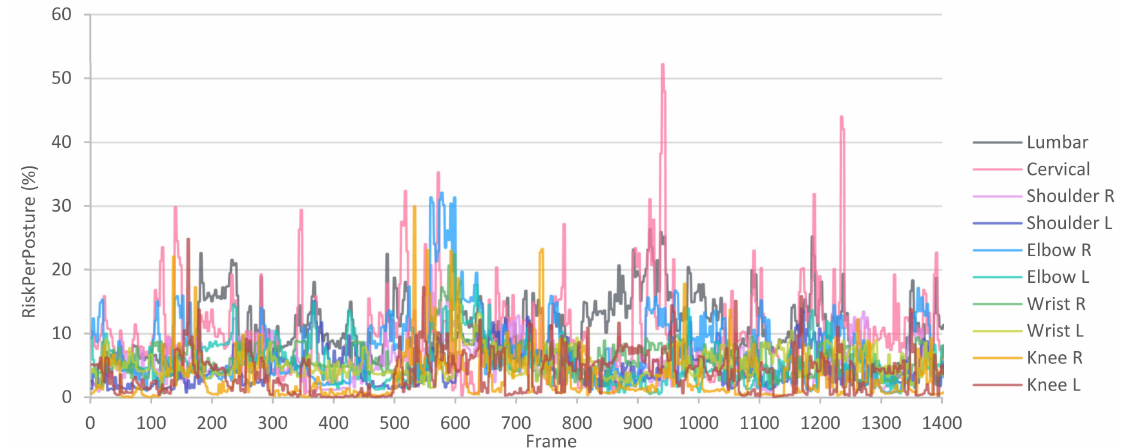
Figure 6. Example of the RiskPerPosture in a set of frames. R: Right side. L: Left side.